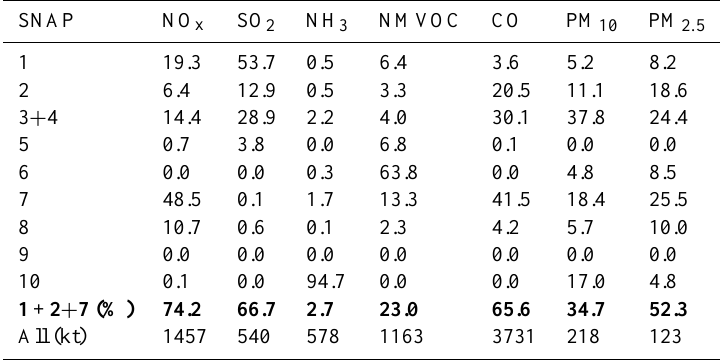
Table 1. Contribution of the different source sectors to German national emissions (%). In addition to single sectors, the relative contribution for the three sectors studied here are also given. Finally, the last row provides the national emission total for all species (kt). SNAP NO x SO 2 NH 3 NMVOC CO PM 10 PM 2 .